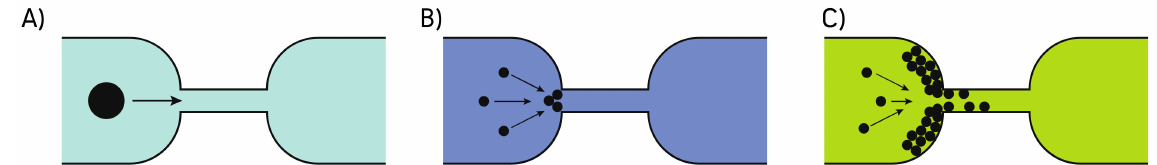
Figure 4. Clogging mechanisms: ( A ) sieving, ( B ) bridging, and ( C )